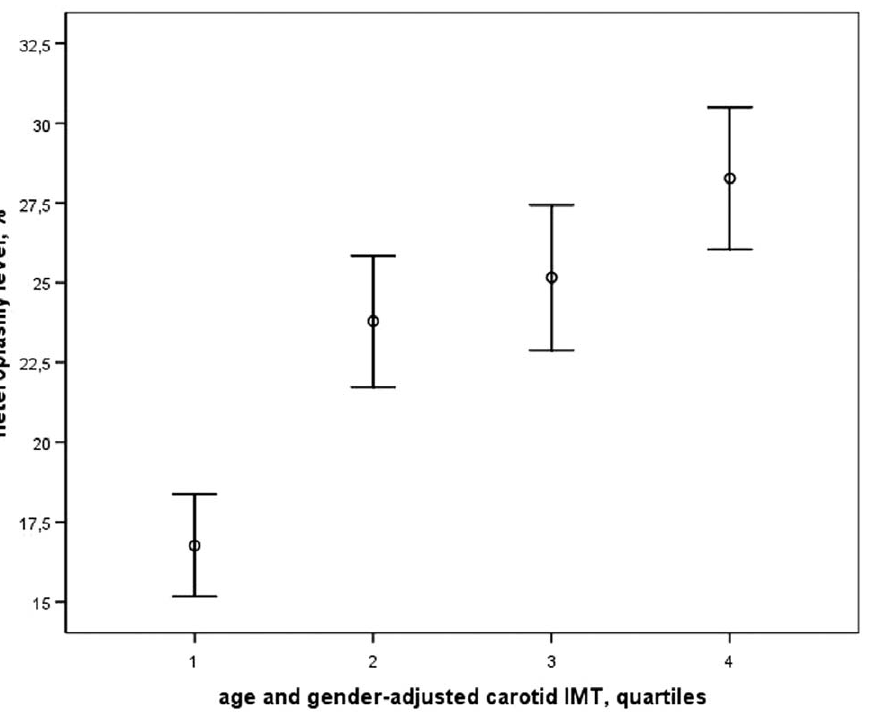
Figure 1. Graph showing the association of the level of C3256T heteroplasmy of mitochondrial DNA from white blood cells with cIMT quartiles. The data are presented as mean values and S.E.M.